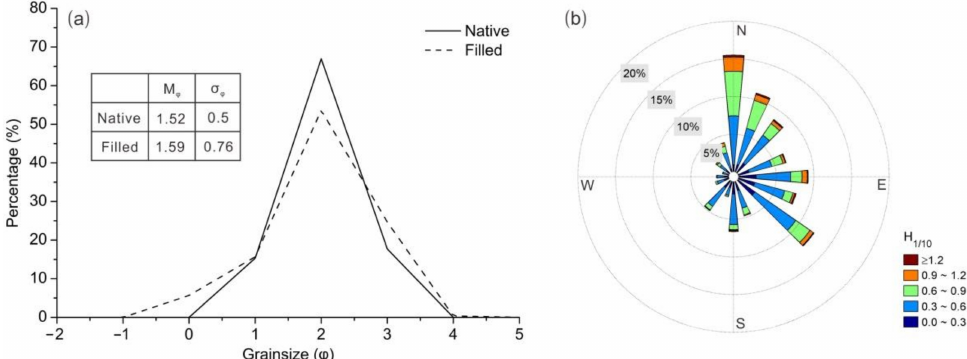
Figure 2. The grainsize distribution for native and borrow sediments ( a ) and rose diagram of annual waves observed from 1 August 2013 to 31 July 2014 near ML beach ( b